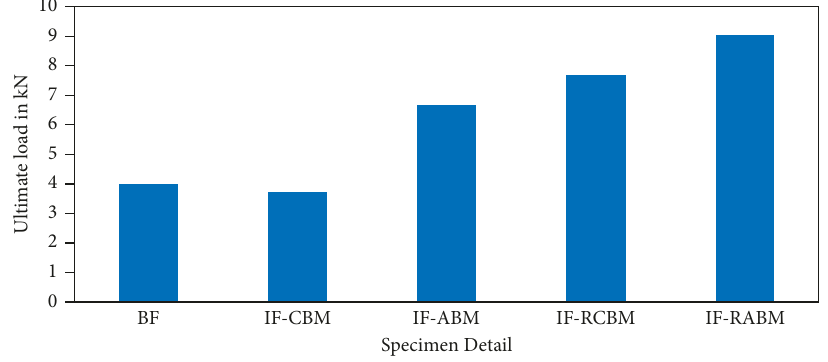
Figure 6: Ultimate load carrying capacity of specimens.